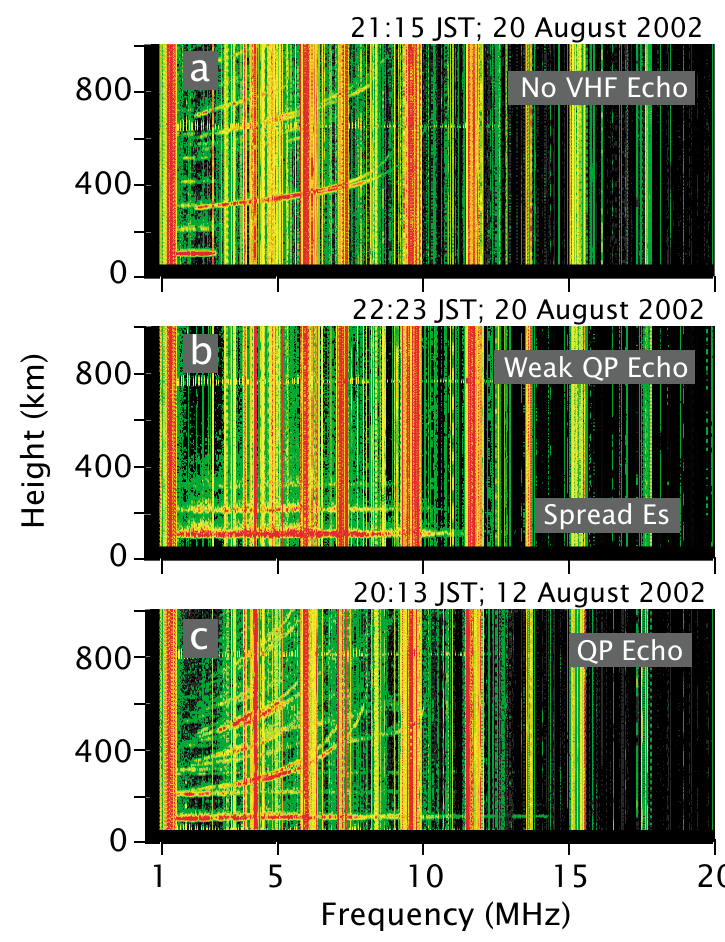
Fig. 2. Different types of ionograms showing a less developed Es trace which is not associated with QP echoes (a) , fully blanketing and a spread Es trace associated with QP echoes (b) , and a transparent, nearly spread Es trace associated with QP echoes (c)